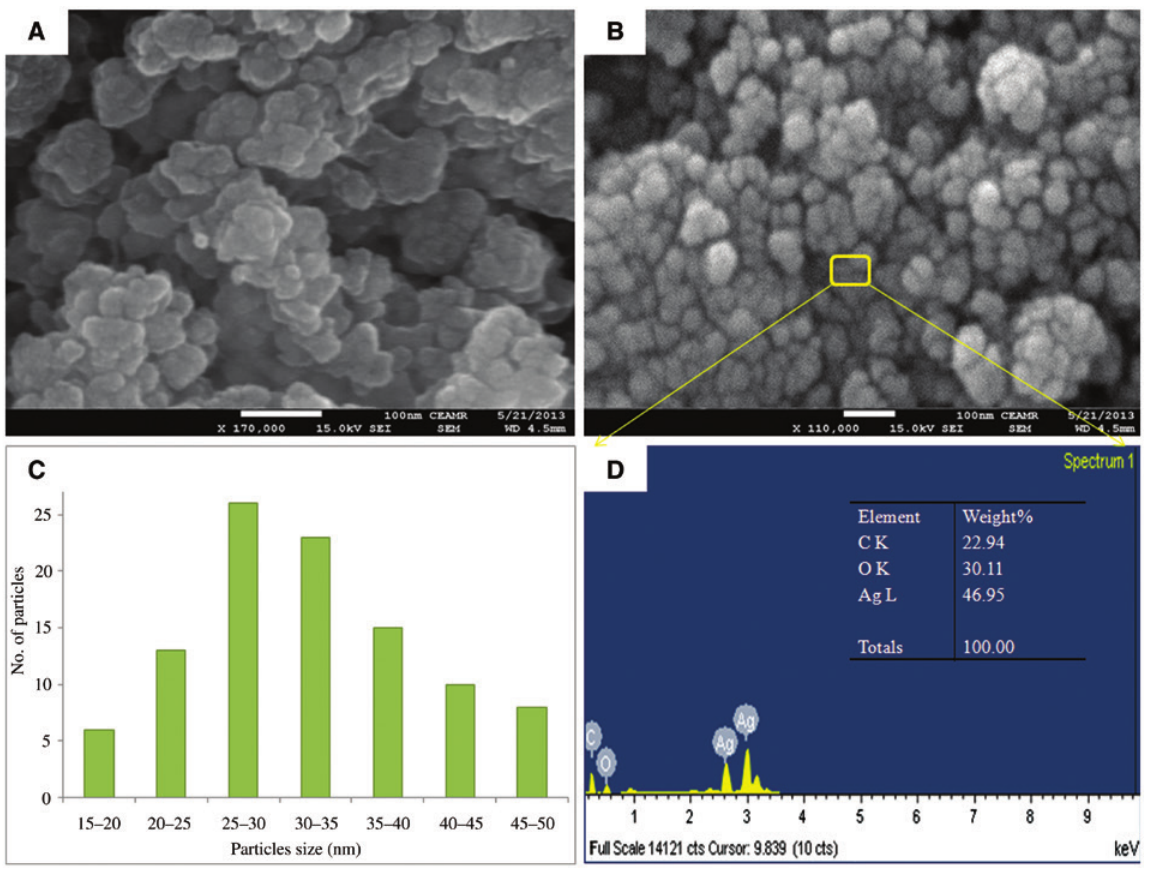
Figure 4: (A and B) High- to low-magnification FE-SEM images, (C) particle size distribution, and (D) EDX investigation of